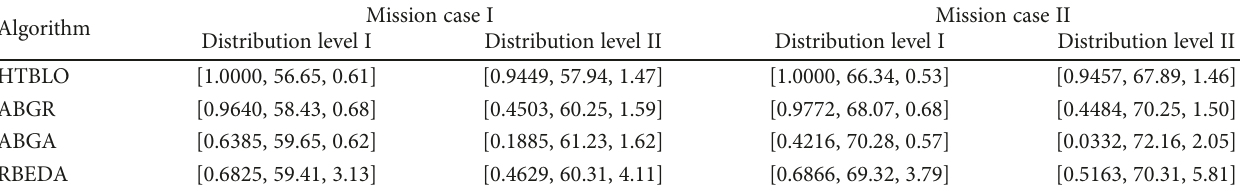
Table 14: Result comparison with other algorithms (25,000 schedules). Algorithm